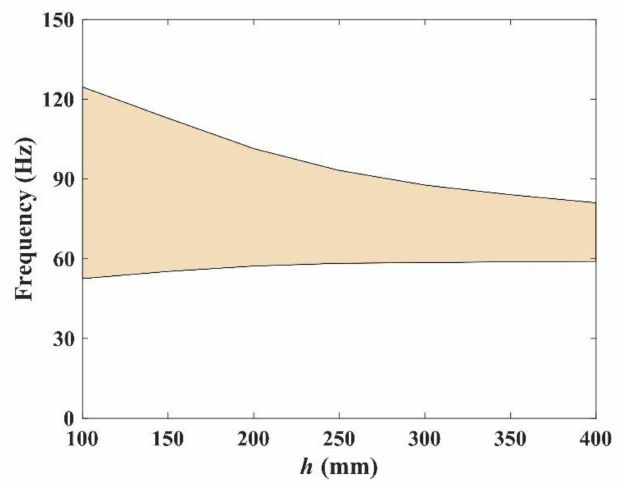
Figure 11. The influence of h on the band